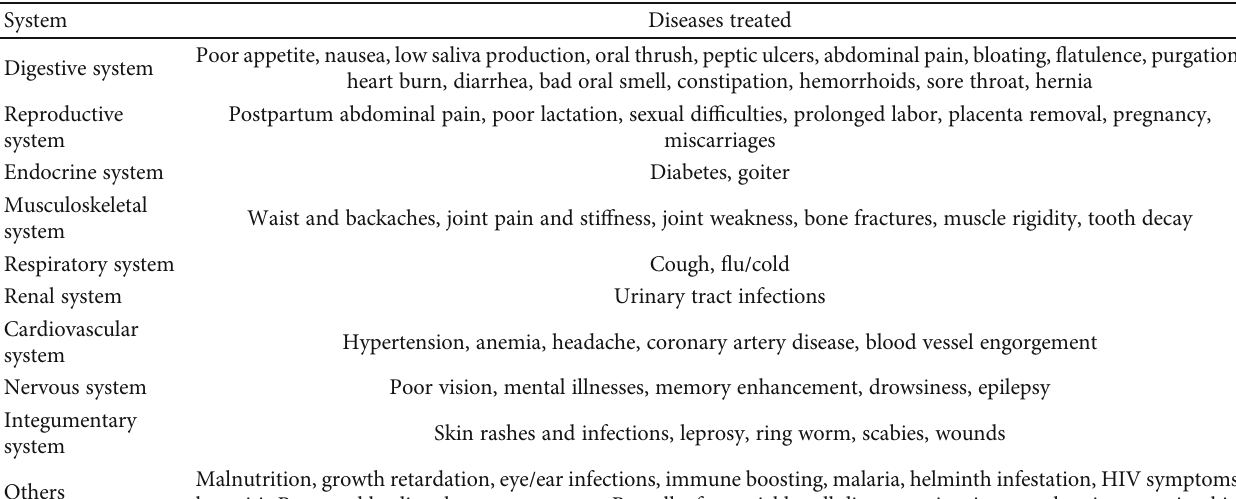
Table 5: Diseases treated by traditional vegetables in Northern Uganda per body